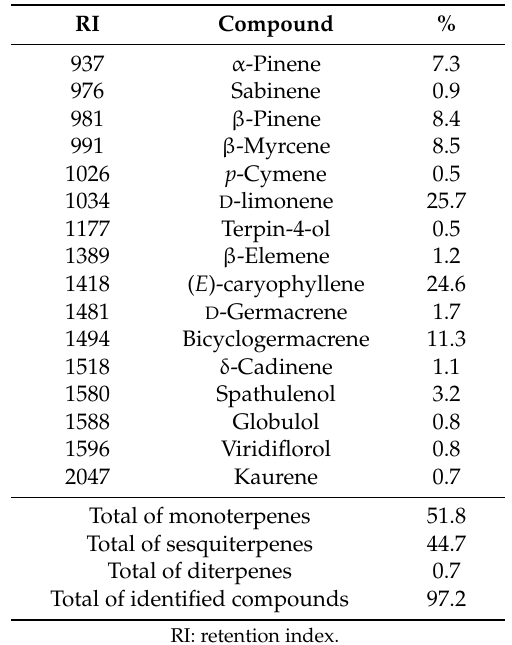
Table 1. Chemical constituents of the essential oil from B. reticularia and their relative abundance.